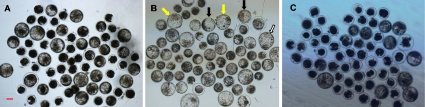
Representative photographs of bovine blastocysts.Day 7 SCNT blastocysts developed from control oocytes (A: control group), BCB+ oocytes (B: BCB+ group), and BCB− oocytes (C: BCB− group). Original magnification was ×40. Bar = 100 µm. Expanded, hatching, and hatched Blastocysts were directed by black, white, and yellow arrows, respectively.